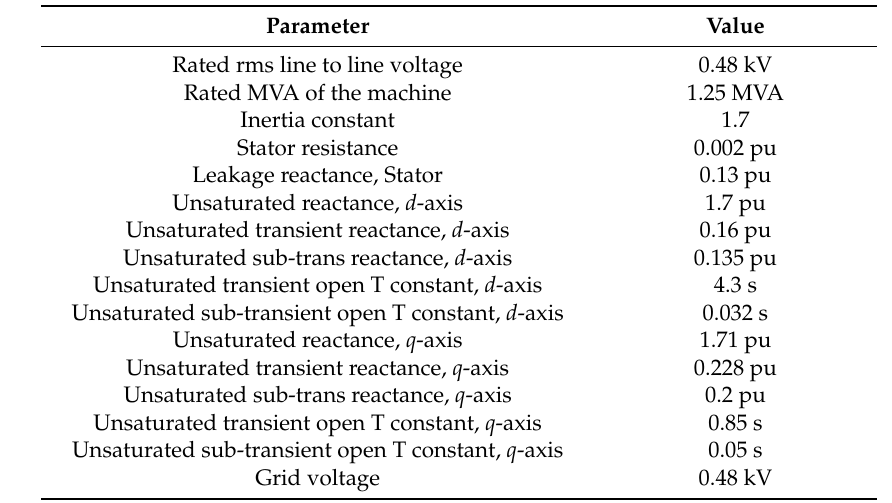
Figure 7. Diesel generator speed governor controller.